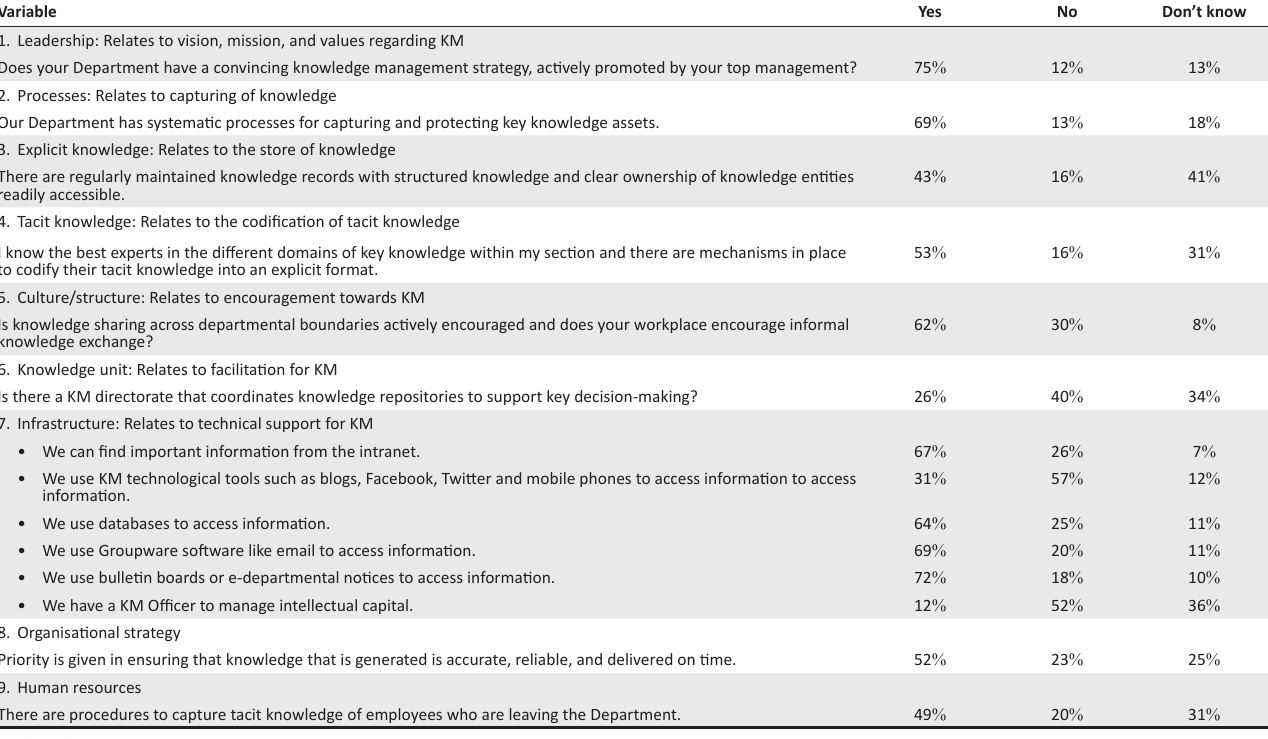
TABLE 1: Knowledge management readiness assessment ( N = 61). Variable Yes No